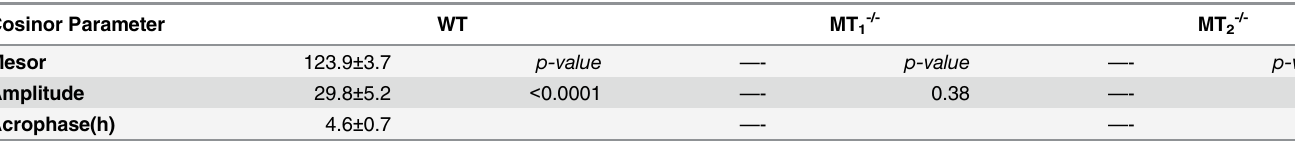
Table 2. Blood glucose rhythms in WT, MT1 -/- & MT2 -/- mice. Cosinor Parameter WT MT 1-/- MT 2-/- Mesor 123.9 ± 3.7 p-value — - p-value — - p-value Amplitude 29.8 ± 5.2 < 0.0001 — - 0.38 — - 0.20 Acrophase(h) — - —